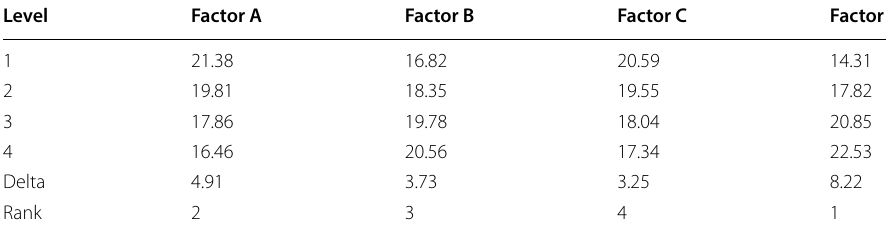
Table 5 Taguchi response table for air temperature drop in EATHE system Level